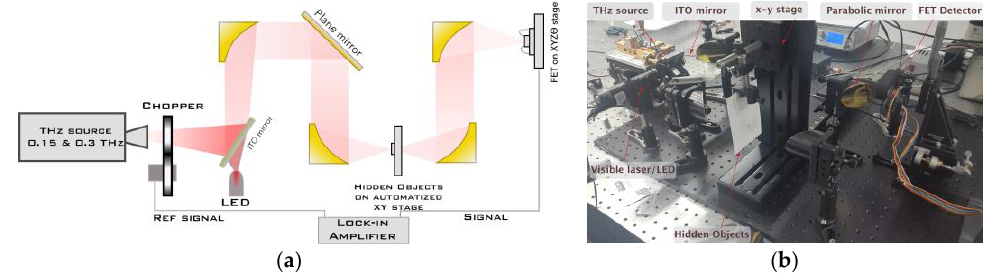
Figure 3. ( a ) Schematic description of the detection and imaging experimental setup: the THz source generated two output frequencies 150 and 300 GHz; ( b ) photograph of the experimental setup. On the upper left corner the source by RPG can be seen; in the center, the automated x-y stage is shown (the sample is placed inside the envelope when the system is used for imaging).